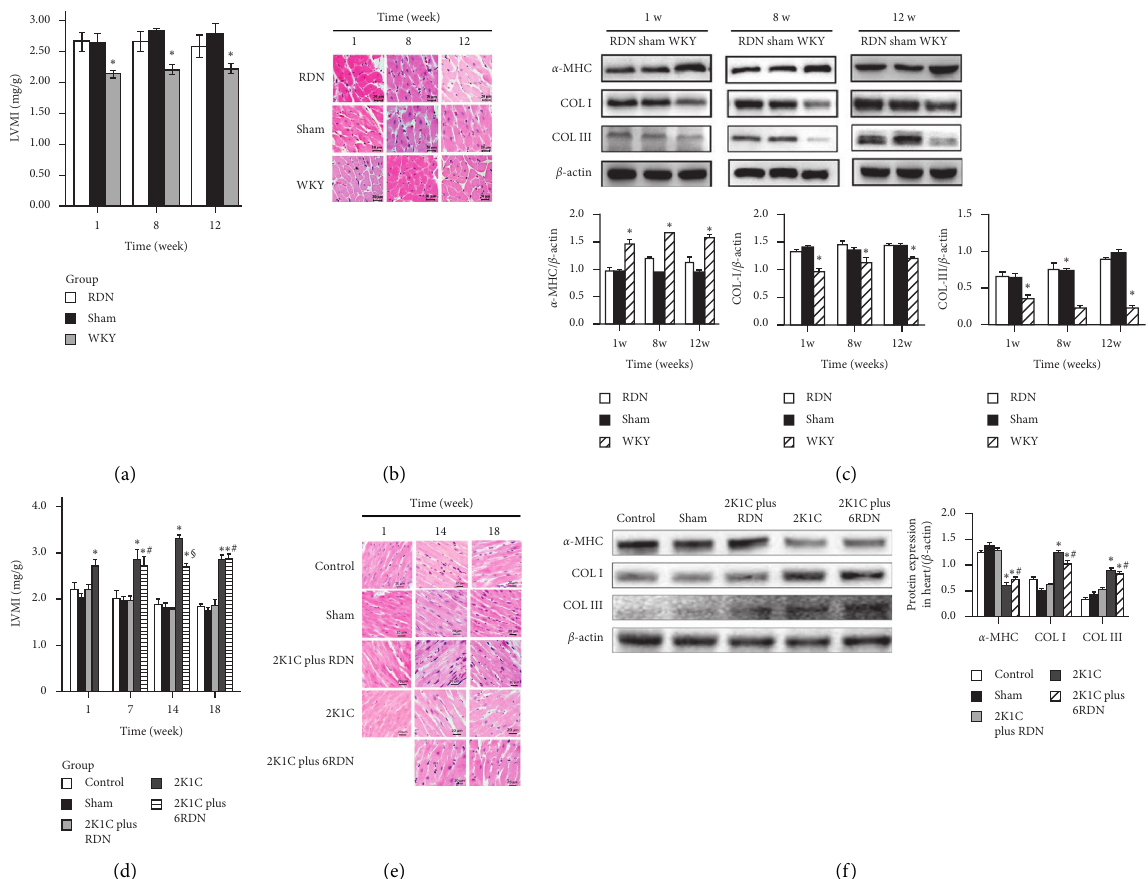
Figure 3: (a) Left ventricular mass index measurement in SHRs. ∗ p < 0 . 05 versus the sham group ( n � 12) at the same time. (b) Car- diomyocytes stained with H&E in SHRs. (c). The expression and quantification of α -MHC, Col I, and Col III protein in left ventricular of SHRs. ∗ p < 0 . 05 versus the sham group ( n � 5) at the same time. (d) Left ventricular mass index measurement in SDs. ∗ p < 0 . 05 versus the control group ( n � 5), sham group ( n � 5), and 2K1C plus RDN group ( n � 5); § p < 0 . 05 versus the 2K1C group ( n � 5); # p > 0 . 05 versus the 2K1C group. (d) Cardiomyocytes stained with H&E in SDs. (e) Cardiomyocytes stained with H&E in SDs. (f) The protein expression and quantification of α -MHC, Col I, and Col III protein in left ventricular of SDs. ∗ p < 0 . 05 versus the control group, sham group, and 2K1C plus RDN group; # p > 0 . 05 versus the 2K1C